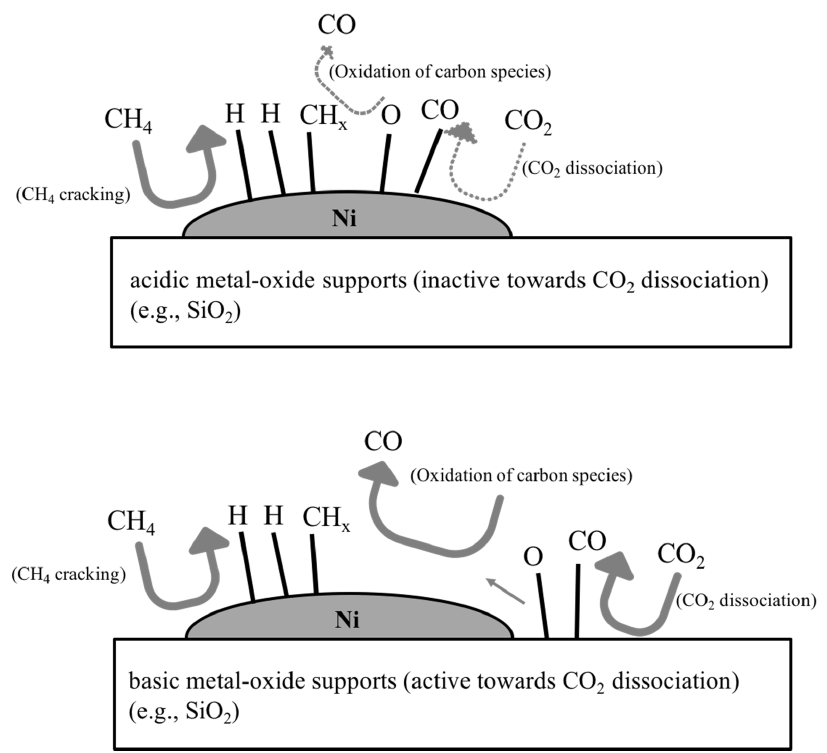
Figure 3. Schematic description of DRM reaction proceeds via three major steps (CH 4 cracking, CO 2 dissociation, and oxidation of carbon species) over Ni particles supported by either acidic (e.g., SiO 2 ) or basic metal ‐ oxide supports (e.g., MgO).